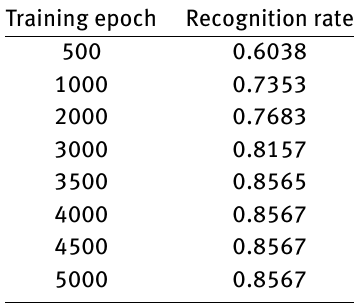
Table 3: Relationship between BP Training Epoch and Recognition Rate